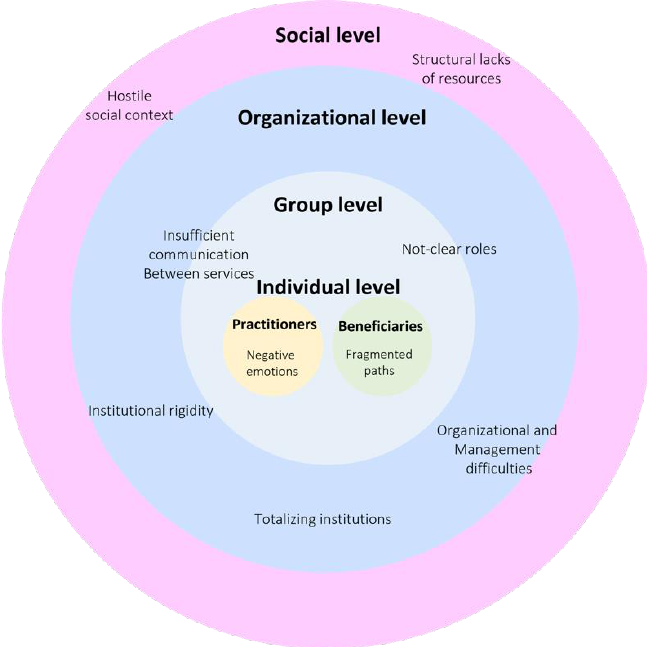
Figure 1. Graphical representation of the service network .